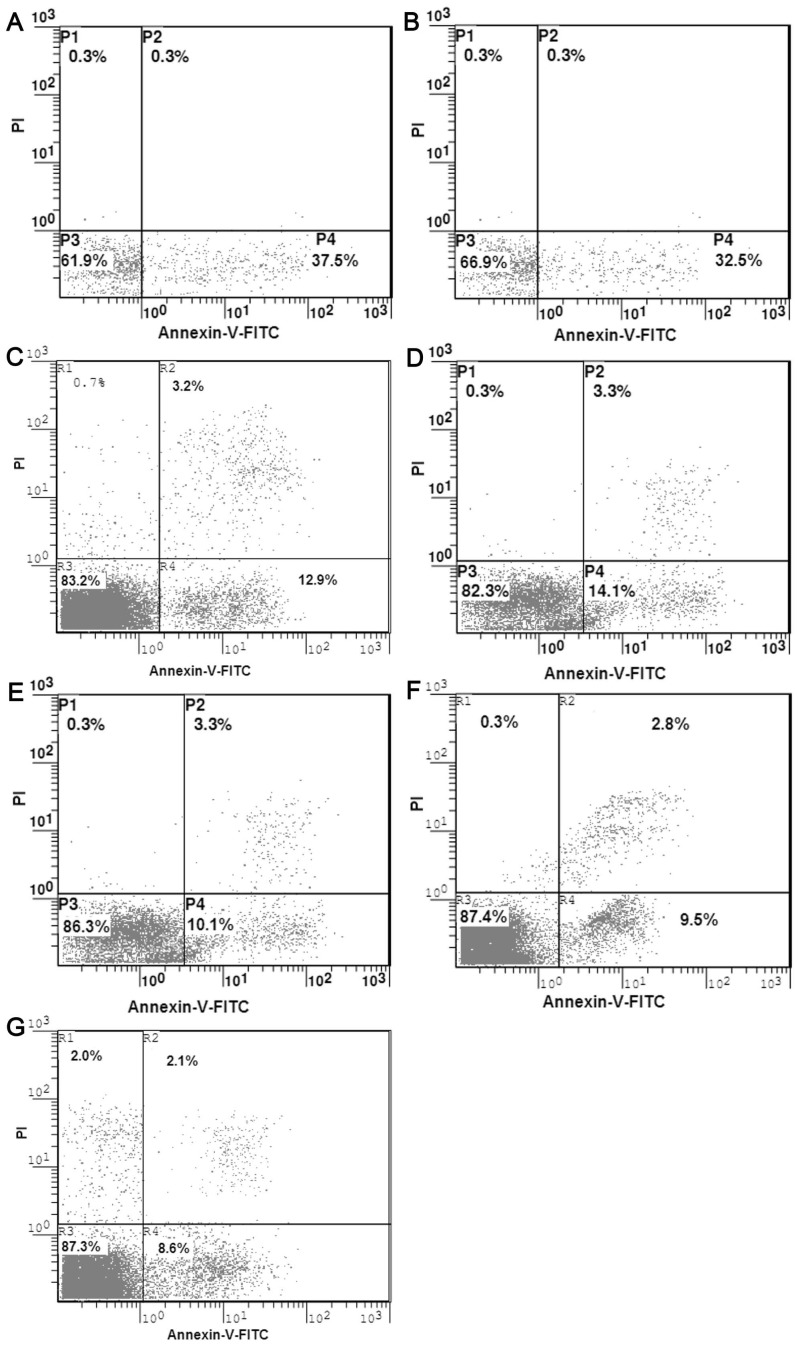
The apoptosis of NIT-1,NIT-vector and NIT-1-hAAT cells were analyzed by flow cytometric(n = 3).Apoptosis of NIT-1 and NIT-vector cells (A) mediated by NIT-1 primed lymphocytesp; Apoptosis of NIT-1 and NIT-vector cells (B) mediated by NIT-vector-primed lymphocytes; Apoptosis of NIT-1(C),NIT-vector(D) mediated by NIT-hAAT primed lymphocytes. Apoptosis of the NIT–hAAT cells mediated by NIT-1-primed(E) and NIT-vector (F)primed lymphocytes;.Apoptosis of the NIT–hAAT cells(G)mediated by NIT–hAAT -primed lymphocytes.